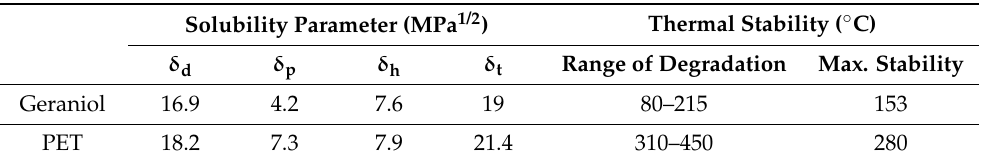
Table 2. Partial Hansen solubility parameters, the total Hildebrand solubility δ t and the thermal stability parameter of geraniol and PET